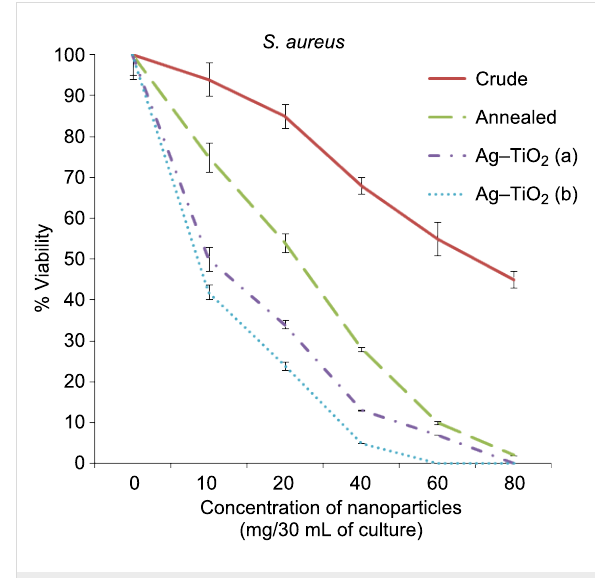
Figure 6: Viability of bacteria ( S. aureus ) against the concentration of nanoparticles (mg/30 mL of culture) in